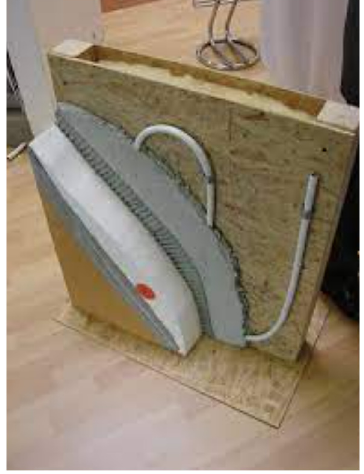
Figure 3. Application of TB on the wall of a timber building [5].